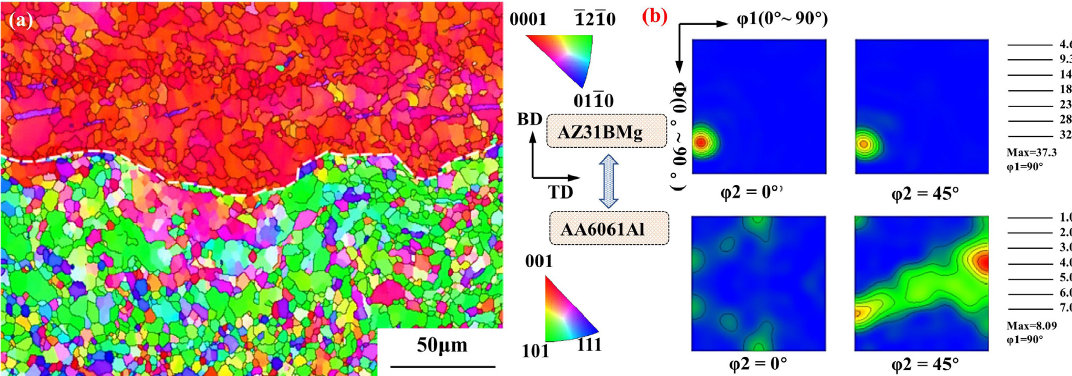
Figure 5. EBSD maps at a welding energy of 980 J (700 ms) (a) IPF (d)